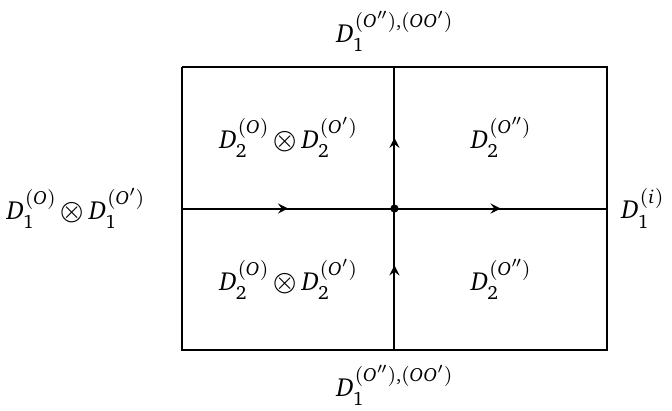
Figure 25: The coefficient n appearing in (54) is the dimension of the vector space i of local operators shown in the